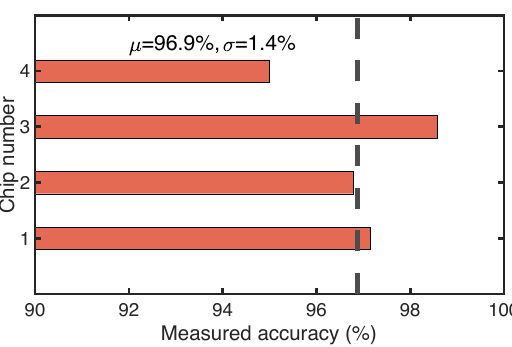
Figure 10. Accuracy versus supply voltage.